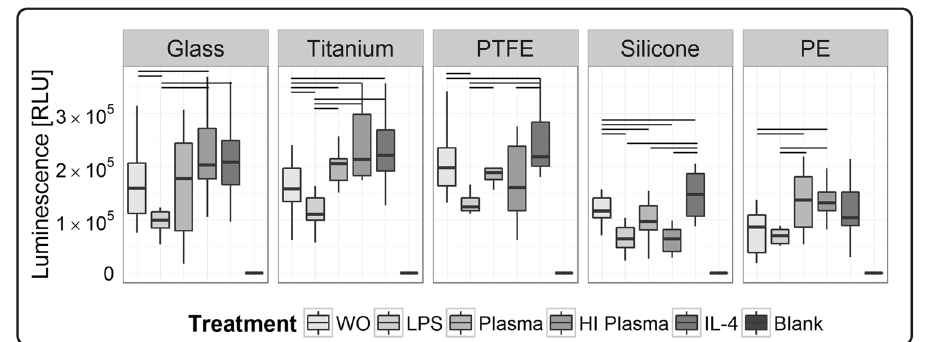
Figure 5. Surface-associated viability of macrophages following test procedure of 48 h was assessed by semi- quantitative ATP measurement, using a luminescence-based assay (CellTiter). Significant differences between the test conditions were found on all tested materials. Data is comprised of ten human macrophage donors (n = 10). Significance level is considered with a p -value ≤ 0.05. The following abbreviations are used: WO for without treatment, HI for